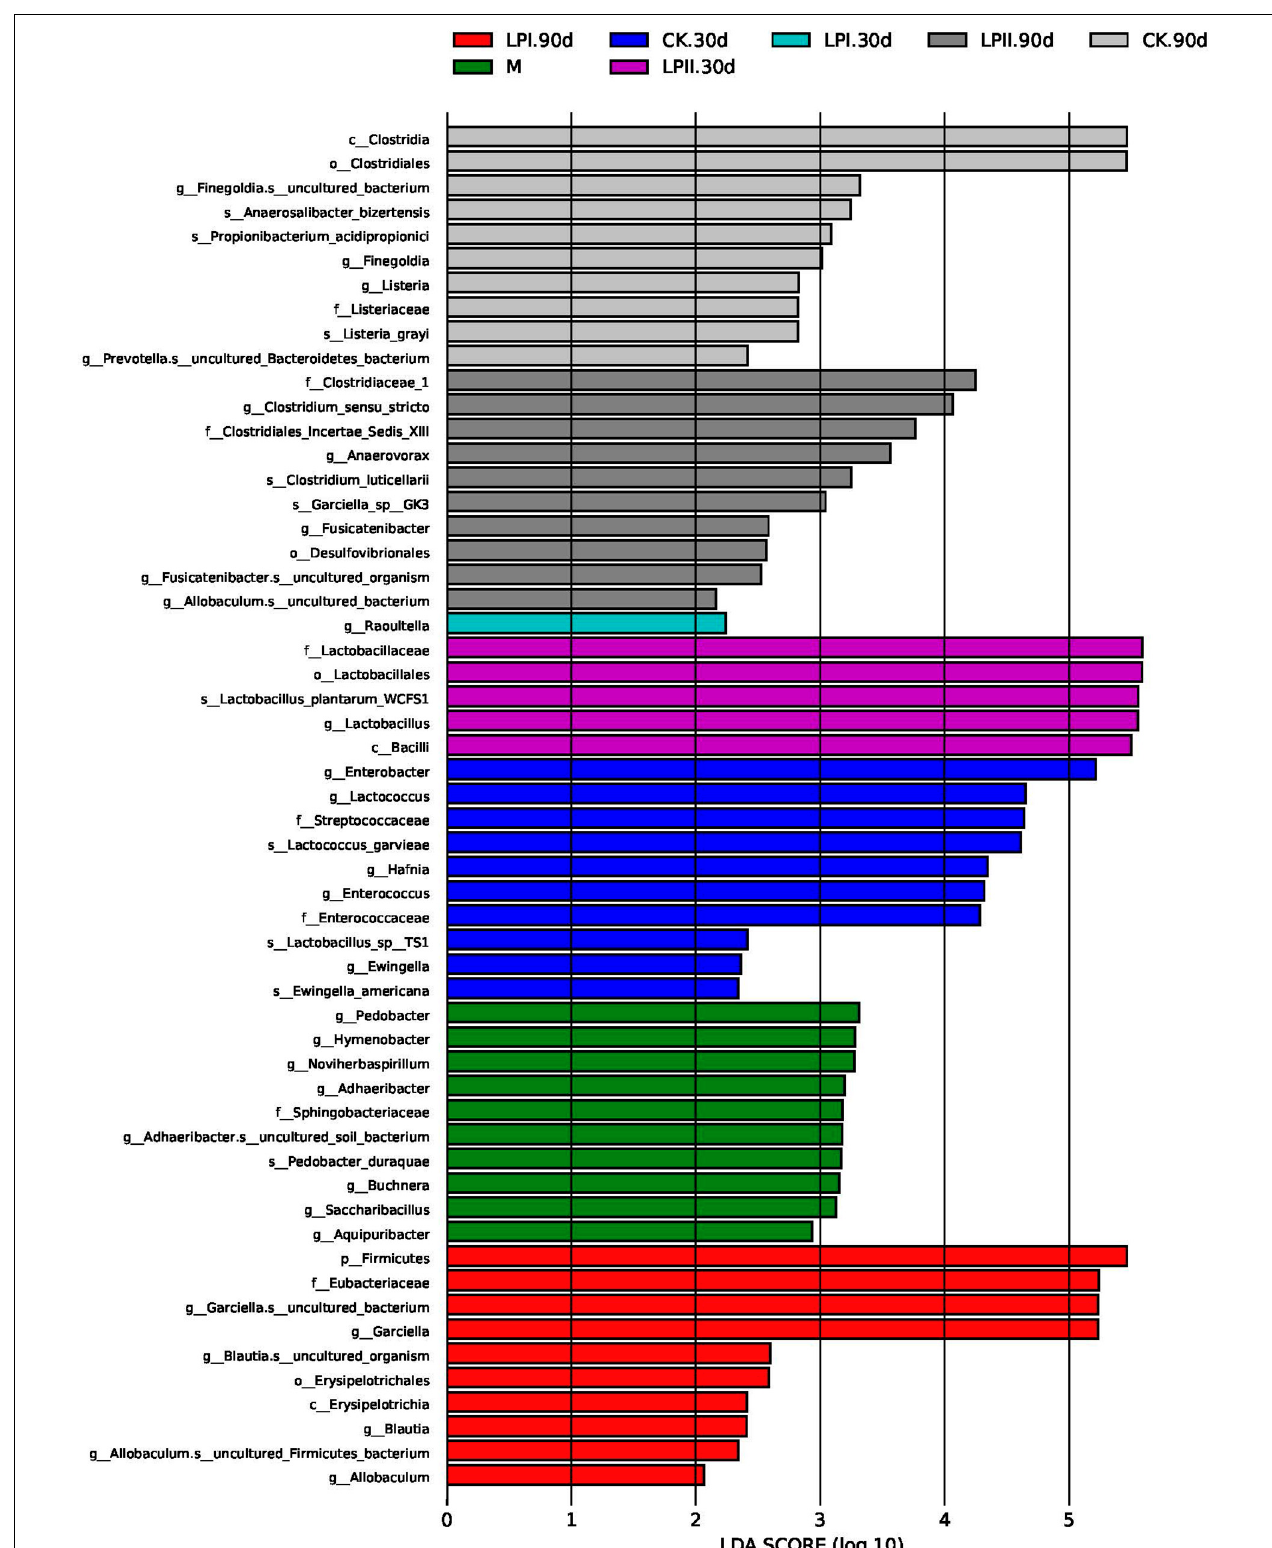
FIGURE 4 | Comparison of microbial variations using LefSe analysis. M, alfalfa material before ensiling; CK, control; LPI, inoculated with L. plantarum YX; LPII, inoculated with L. plantarum A345. The numbers following CK, LPI, and LPII stand for ensiled days of silage.